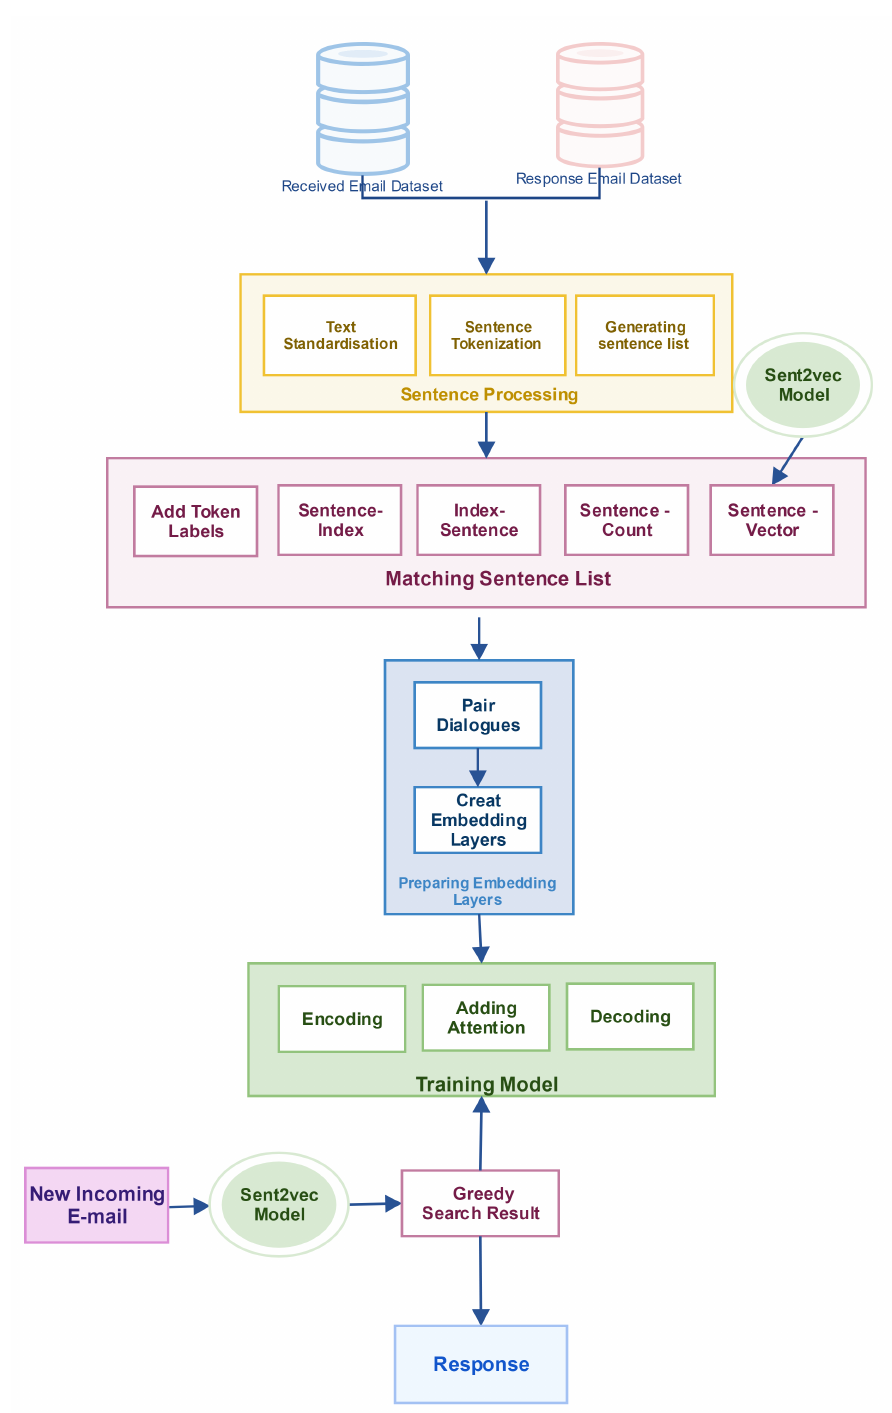
Figure 4. Gated Recurrent Unit Sentence to Vector (GRU-Sent2Vec) Hybrid